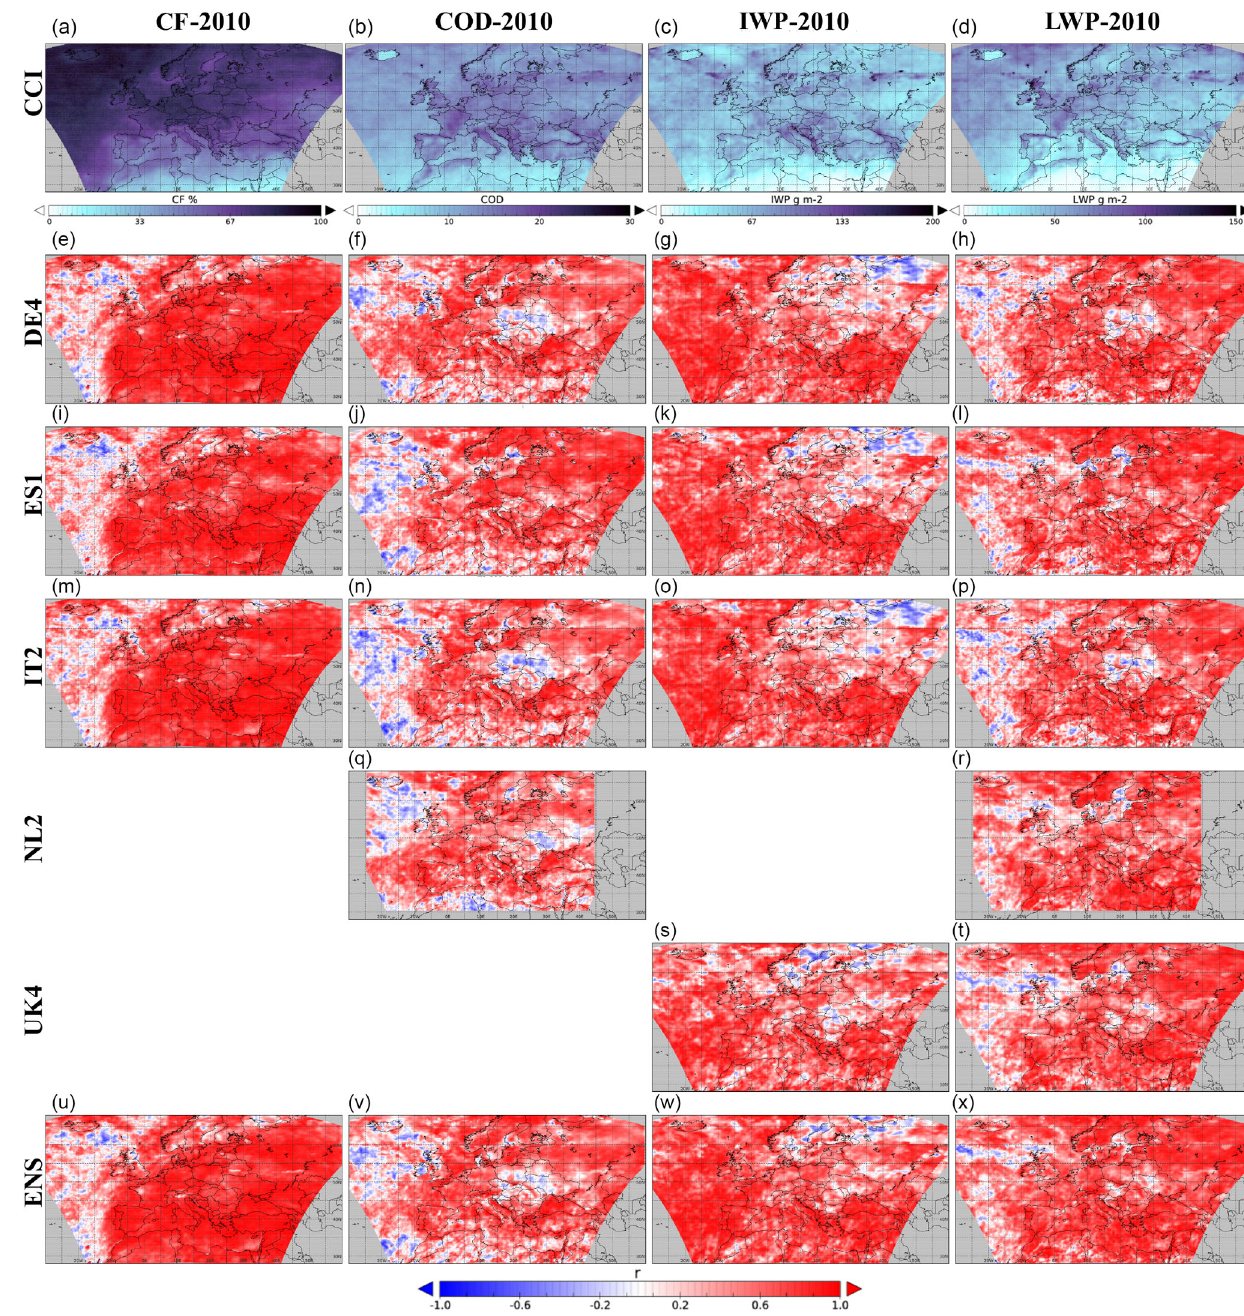
Figure 2. Temporal correlation for the whole year 2010. First row represents the mean satellite values of 2010, where each column represents a cloud variable. The following rows show the temporal correlation of each model and cloud